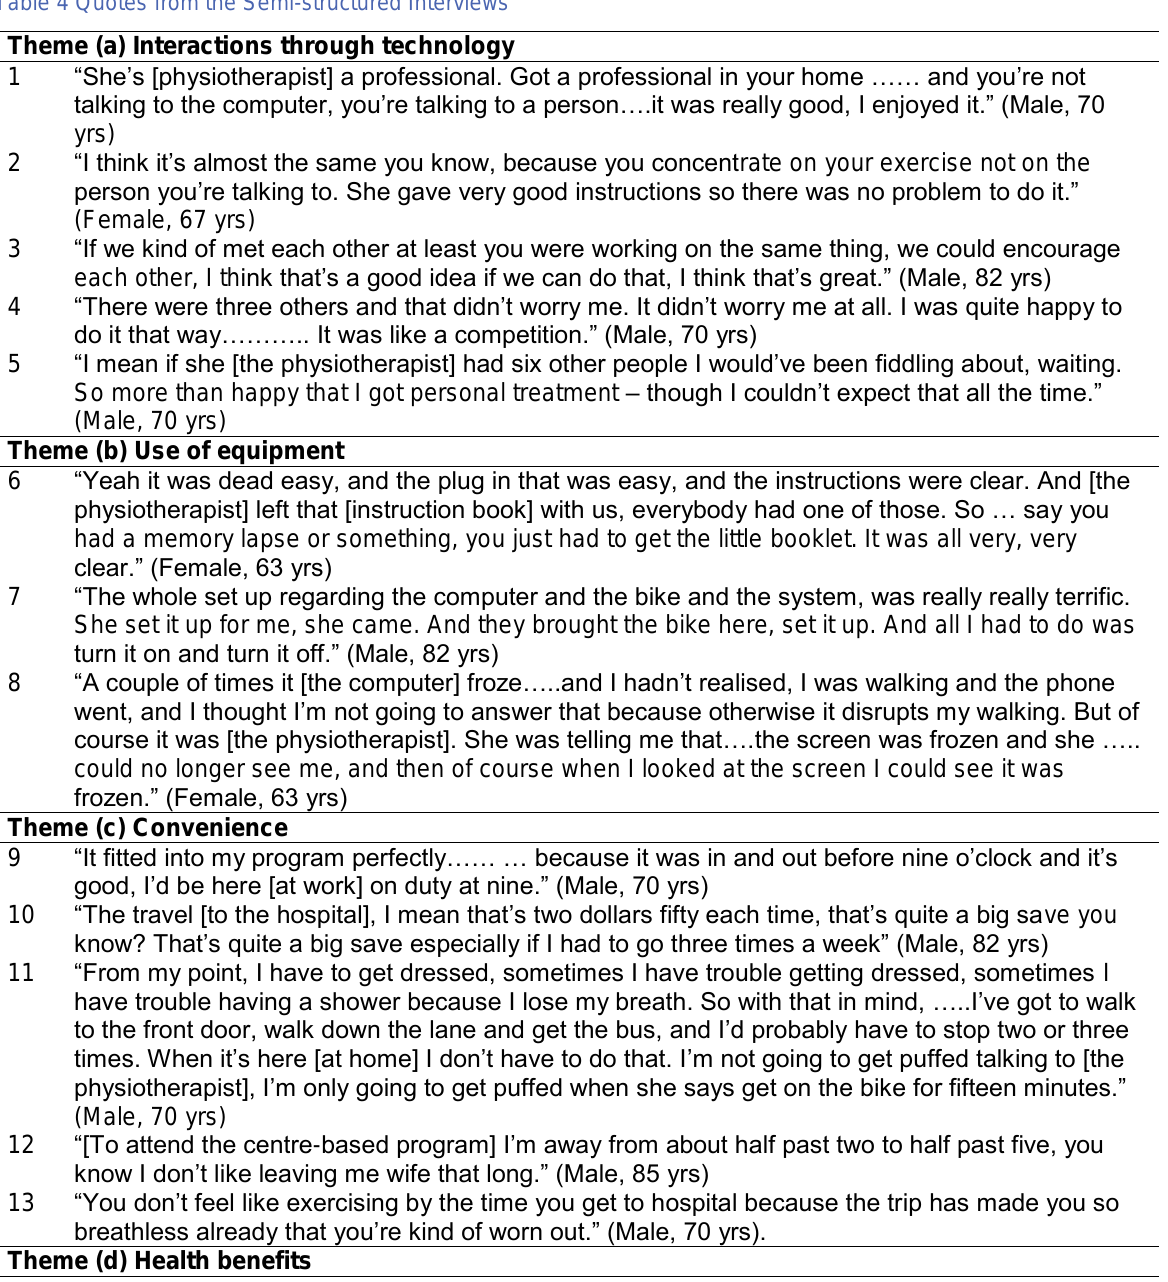
Table 4 Quotes from the Semi-structured